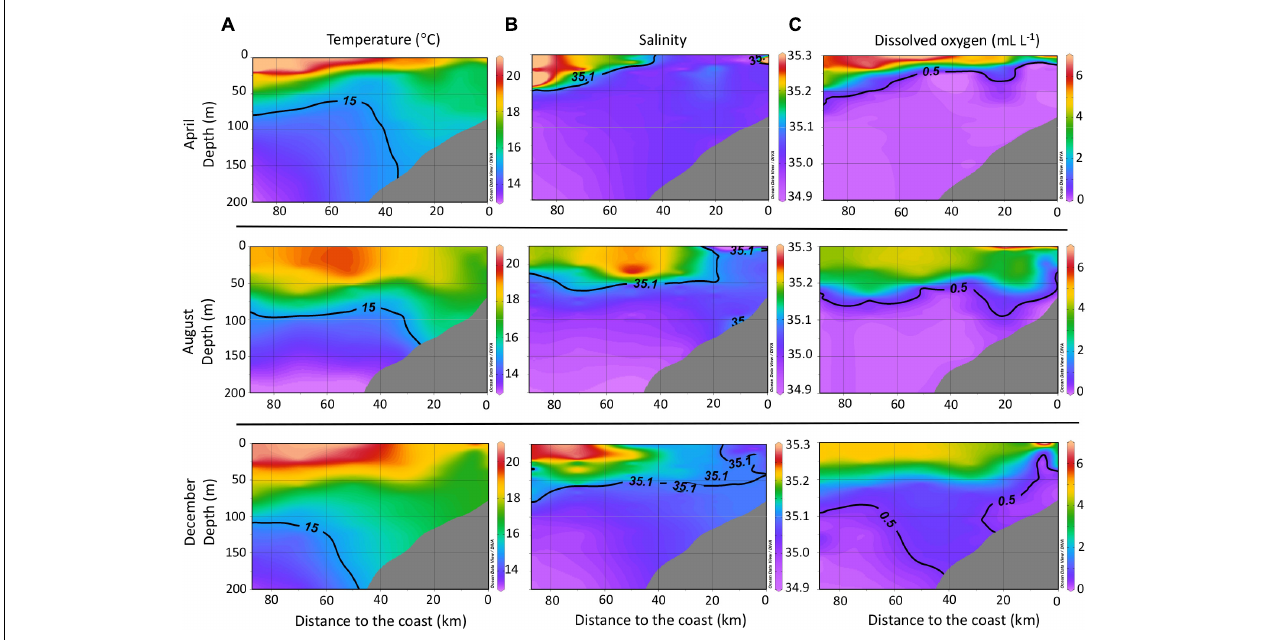
FIGURE 2 | Profiles of temperature (A) , salinity (B) , and dissolved oxygen concentration (C) for the studied transect off central Peru (Callao – 12 ◦ S) during 2015, including all data collected during the CTD casts for the whole transect off central Peru ( Figure 1 ) and not only stations where water samples for DOM analysis were collected. Interpolation was done using the DIVA gridding function in